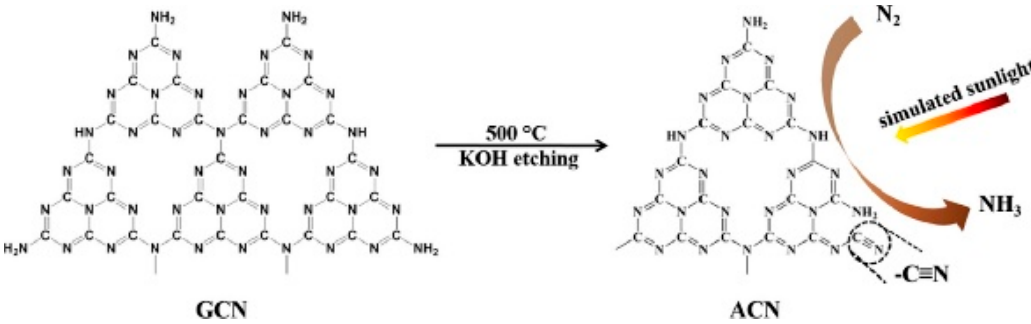
Figure 12. The cyano defects were successfully introduced into the g-C 3 N 4 framework by KOH etching and could contribute to improving the nitrogen photofixation ability of g-C 3 N 4 . (Reproduced with permission from Elsevier with permission from Elsevier [69]).